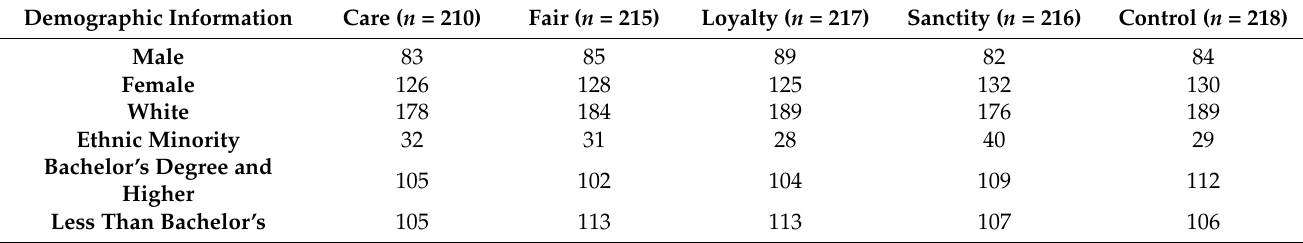
Table 1. Internal Validity of